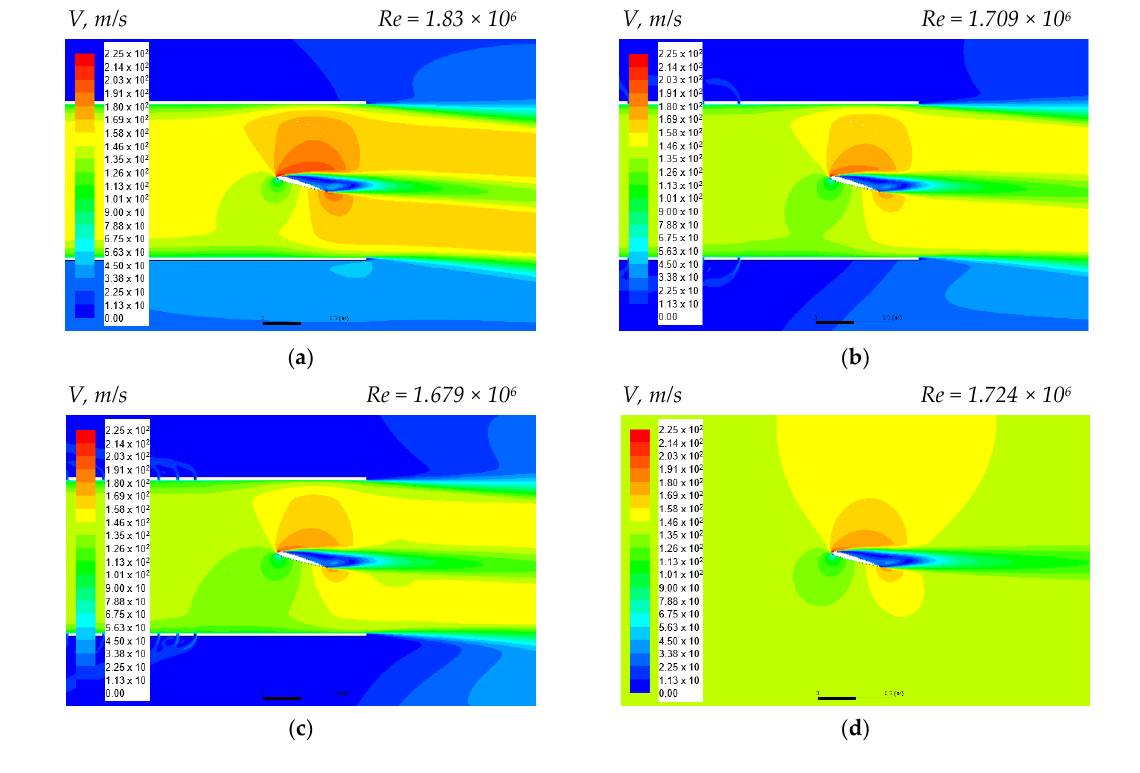
Figure 4. Distribution of the velocity field for various perforation percentage values and for free flow (α = 16°, М = 0.4): ( a )—perforation 0% (solid walls); ( b )—perforation 7.5%; ( c )—perforation 15%; ( d )—free flow.